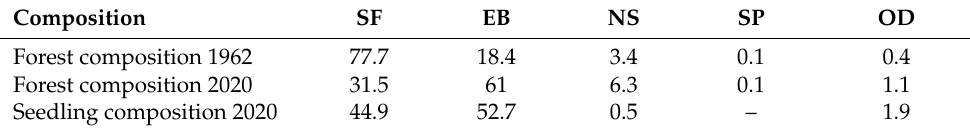
Table 3. Forest composition at the mixed beech–coniferous stand level in the key area.